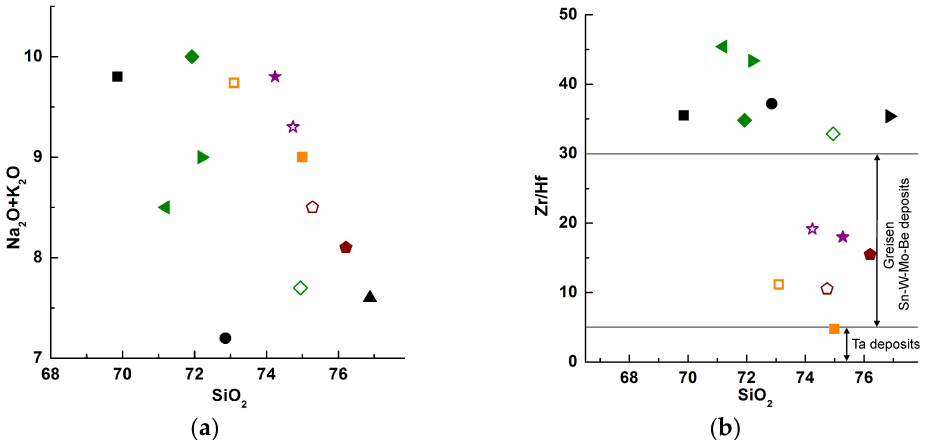
Figure 10. Chemical compositions of the rocks considered in the work: ( a ) petrochemical diagram (Na 2 O + K 2 O)–SiO 2 in wt%; ( b ) diagram of the degree of crystallization differentiation (Zr/Hf)–SiO 2 wt%, according to [59]. The legend is the same as that shown in Figure 9.